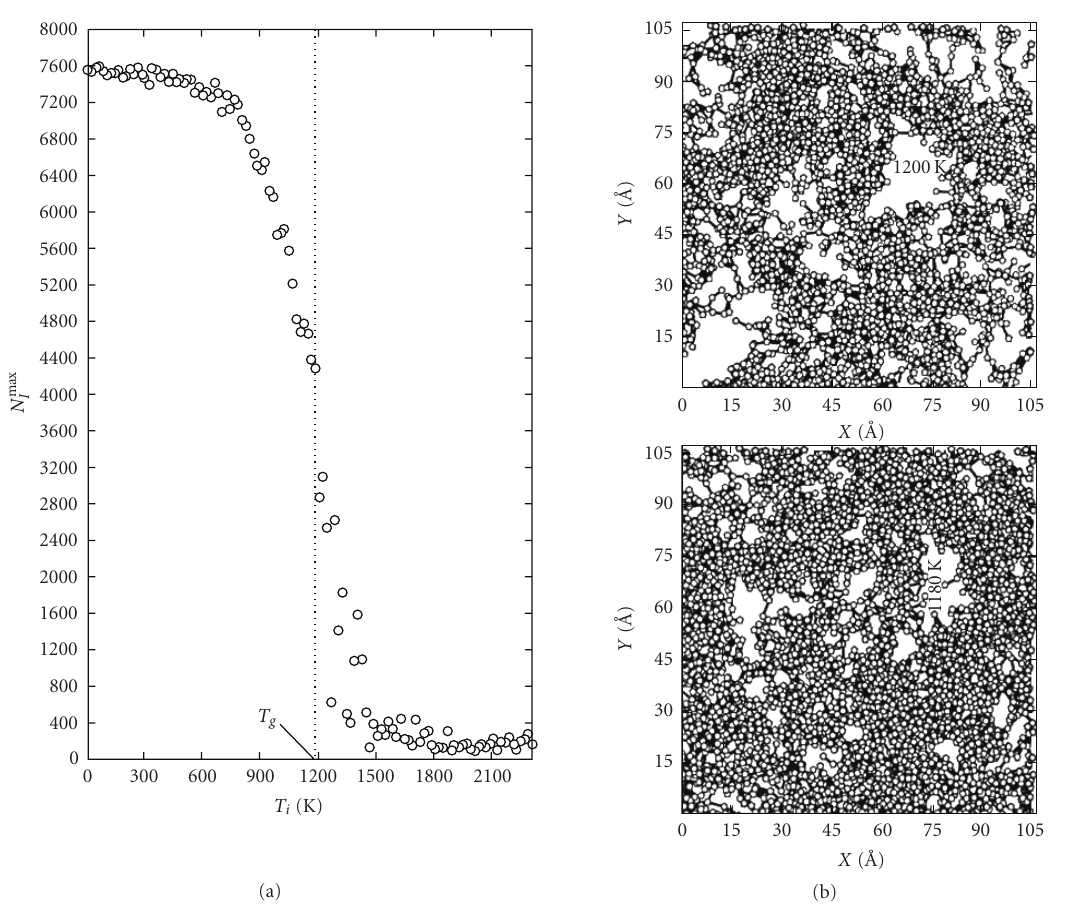
Figure 10: The structure of amorphous iron resulting from molecular dynamics simulations [69]. (a) The size of the largest cluster formed by clustered icosahedrons with the temperature T i . (b) Projections of the largest cluster formed by clustered icosahedrons onto one of the faces of the computational cell at temperatures 1200 K ( 2 ) and 1180 K ( 5 ). Courtesy Alexander Evteev.